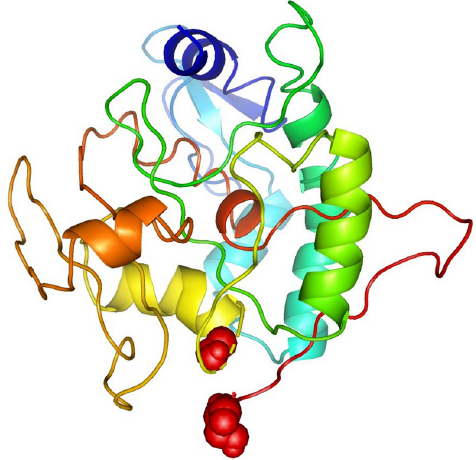
Fig 4. Disulfide engineering to improve protein stability. Displaying 1 magenta coloured mutated residue pair. These residues were selected based on their chi3 value, B-factor, and